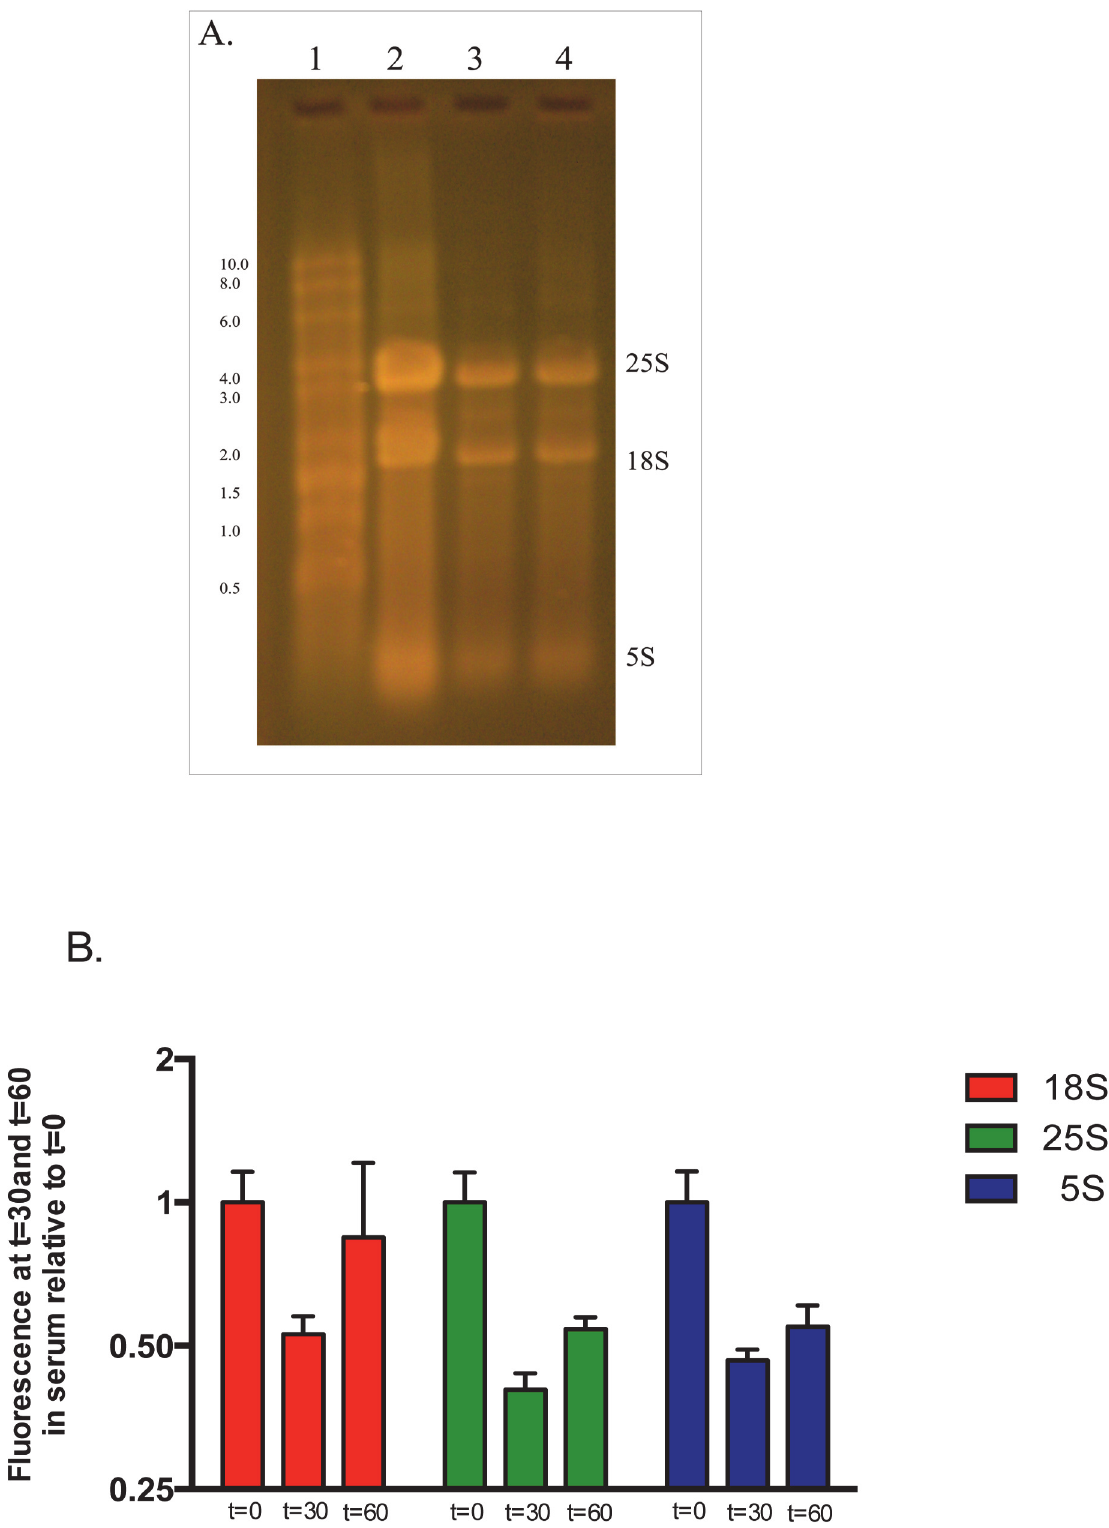
Fig 4. Assessments specific for ribosomal RNAs before and after hyphal stimulation in 10% FBS in H 2 O up to 60 minutes. A. RNA was gel separated and stained with SYBR Gold stain. Lane 1 has RNA size markers. 5 μ l of RNA were loaded in each lane as follows: Lane 2- prior to stimulation, Lane 3 after